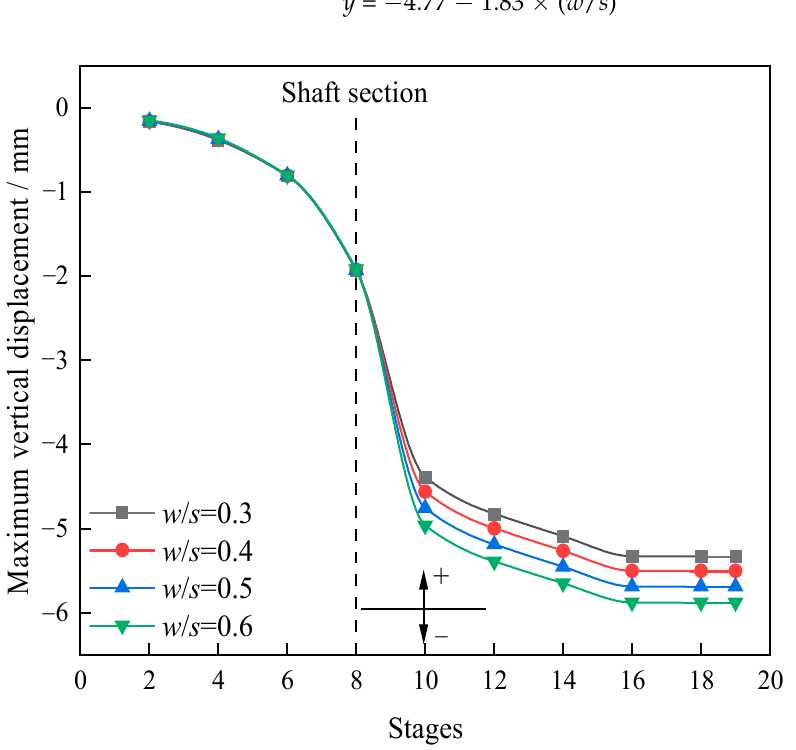
Figure 23. Vertical displacement curve of the tunnel vault.